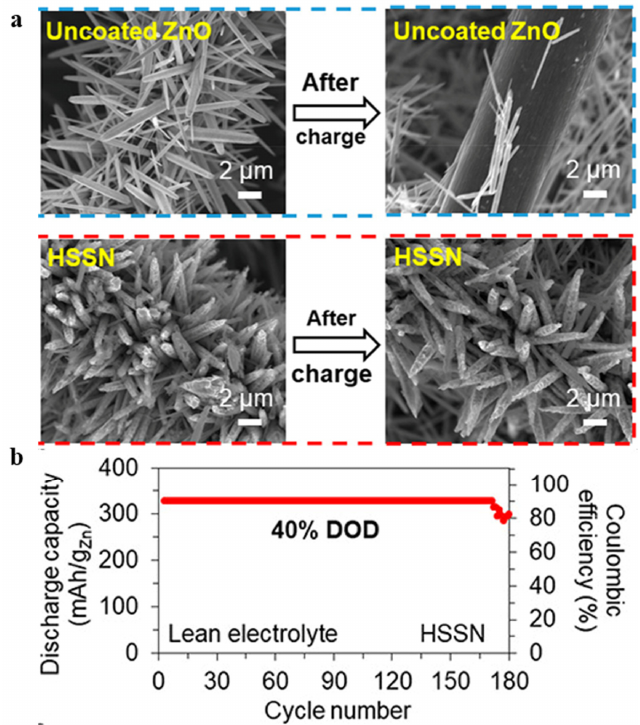
Figure 8. ( a ) SEM images for uncoated ZnO anode and the ZnO@TiO 2 (HSSN) anode before and after charging. ( b ) Cycling performance of the HSSN anode at 40% DOD in the minimal